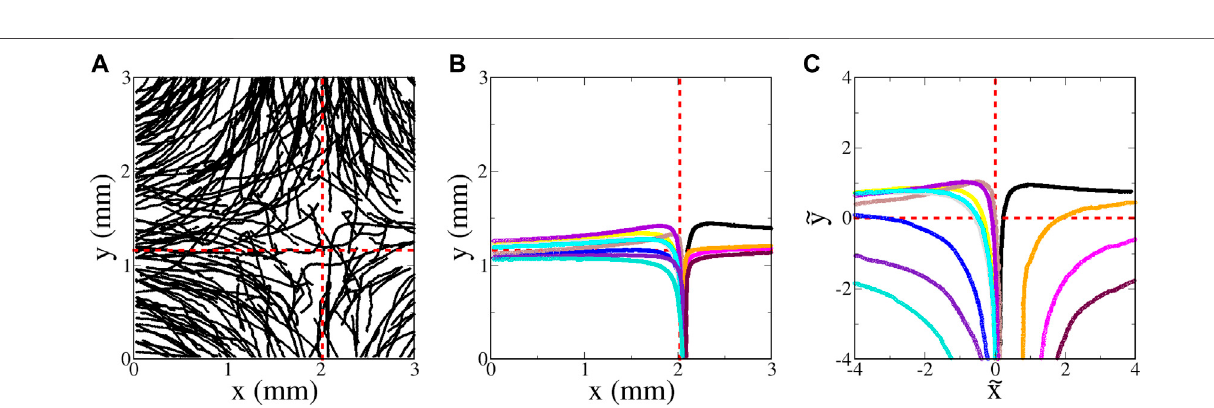
Frontiers in Physics |